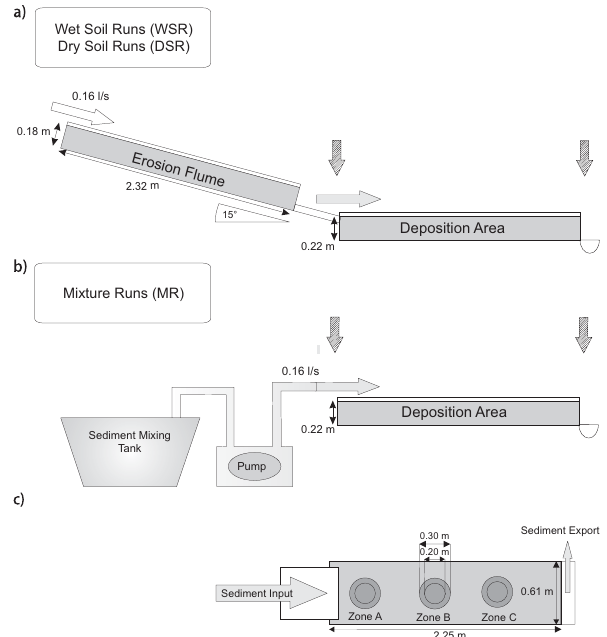
Fig. 1. Schematic sideview diagram of of experimental set-up for the three types of simulation experiments: (A) wet soil runs (WSR), dry soil runs (DSR) and (B) mixture runs (MR). (C) Top view di- agram of the depositional area with deposition zones A, B and C and location of inner and outer PVC rings, extracted for CO 2 -efflux measurements. Vertical arrows in (A) and (B) indicate runoff sam- pling